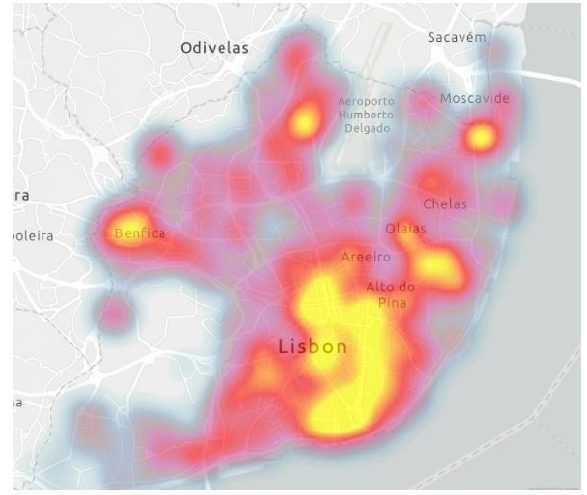
Figure 3. Heatmap—Distribution of incidents in the city of Lisbon.